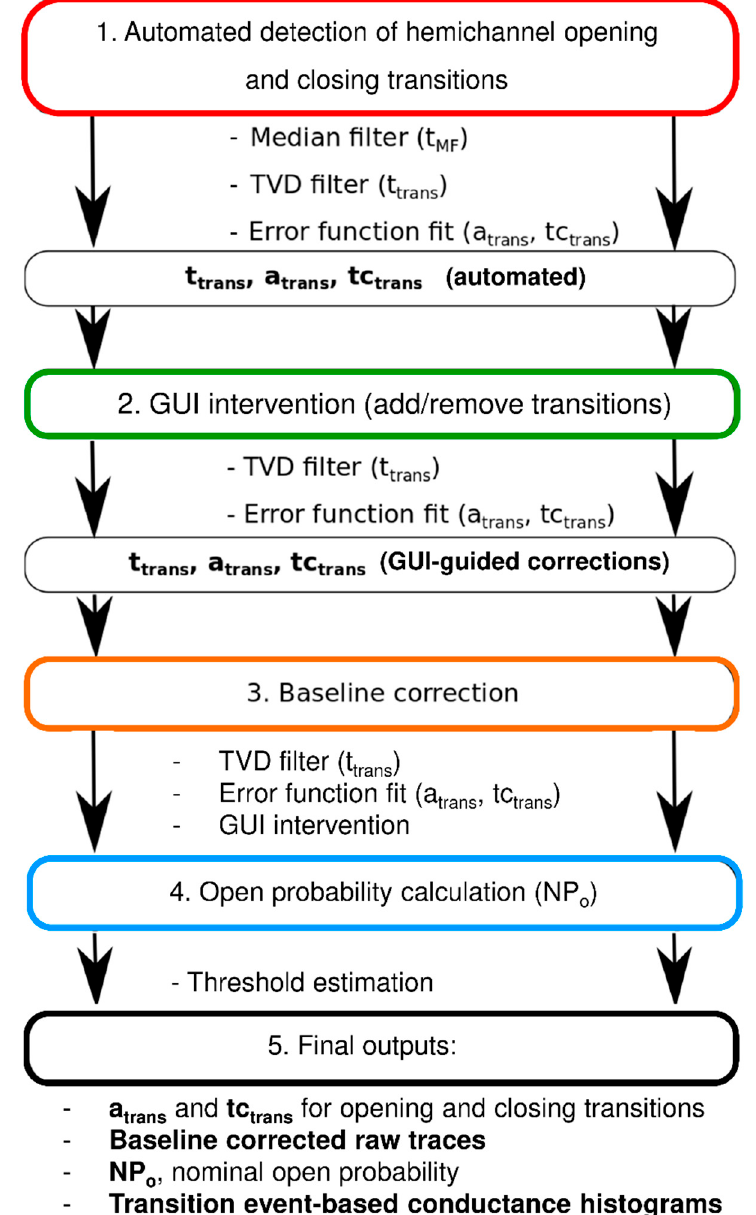
Figure 1. Flowchart of semi-automated analysis of unitary hemichannel currents.